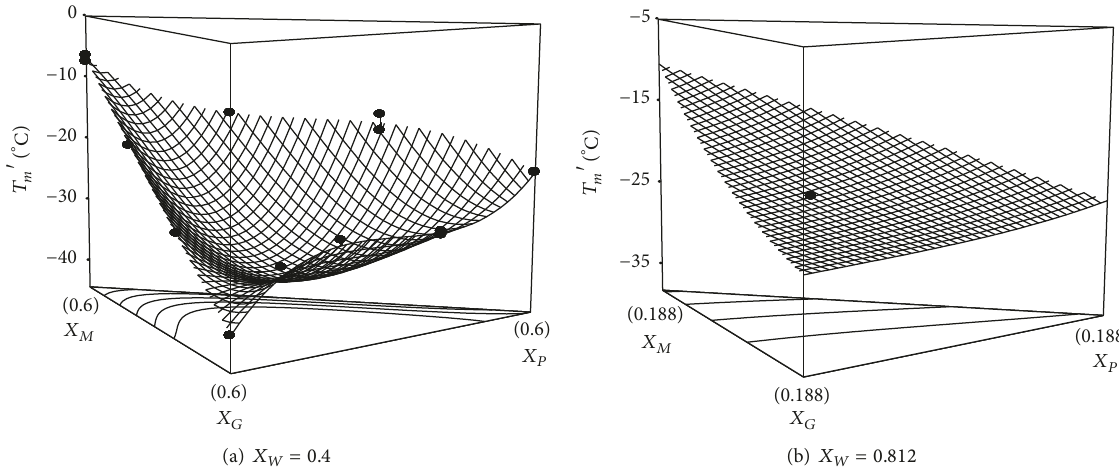
󸀠 for different cryoprotectant solutions: m